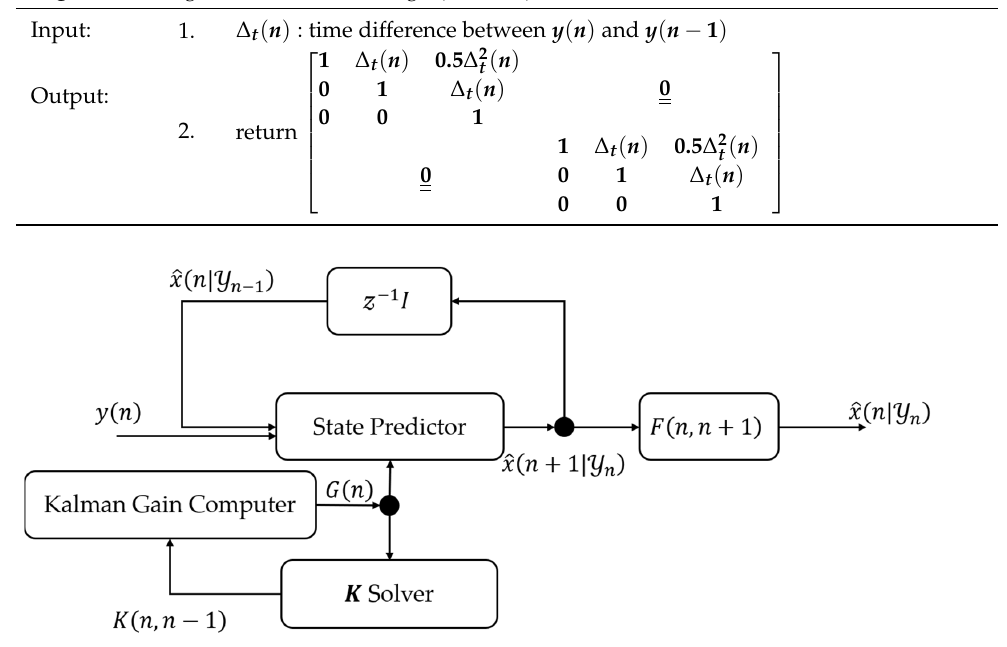
Figure 7. The block diagram of the Kalman Filter. Algorithm 1 Algorithm for Kalman Filter [33].